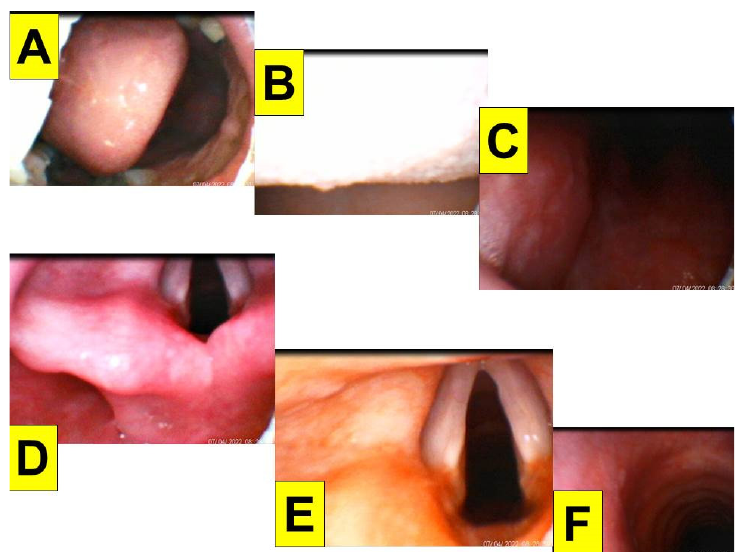
Figure 4. Various views displayed at the video monitor of the intubating stylet through a piece of plastic sheet barrier. ( A ) Entry of oral cavity; ( B ) partial view of tongue and oral space; ( C ) pharyngeal space; ( D ) arytenoid cartilages; ( E ) glottic view with open vocal cords; ( F ) intra-tracheal space. The time for intubation (from lip to trachea) is 8 s (see also the video clip in the Supplementary Materials Video